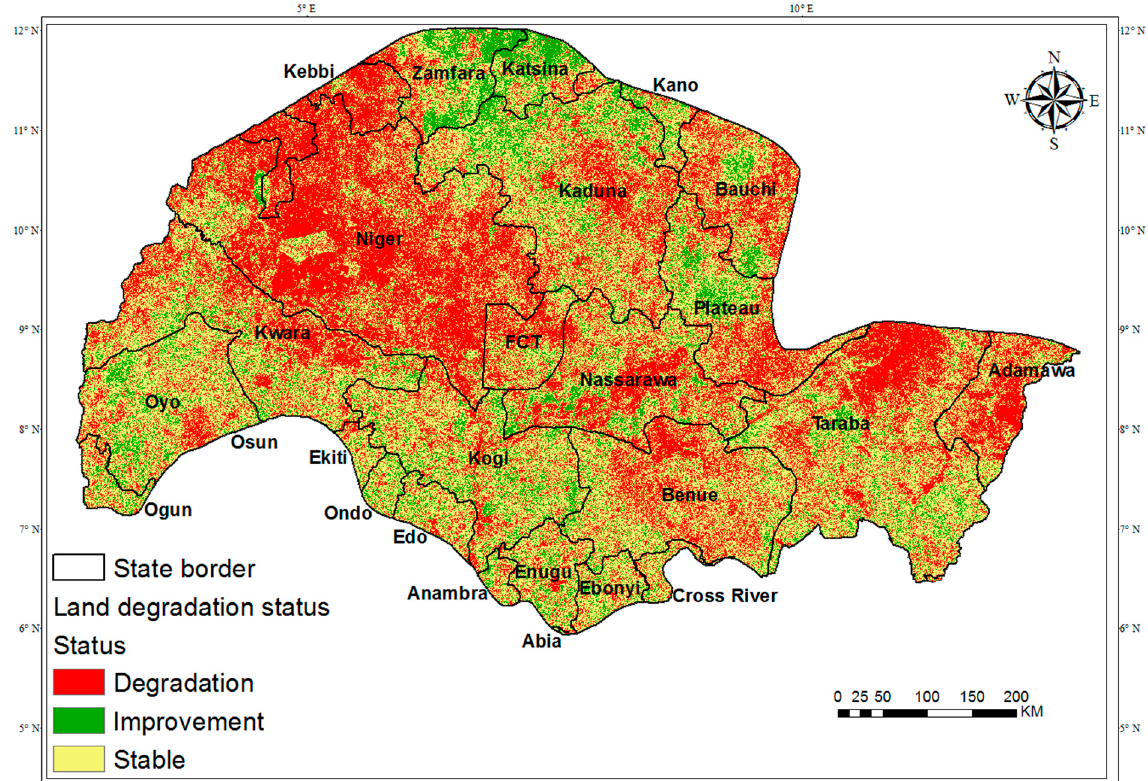
Figure 4. Land-degradation (LD) status for the Nigerian Guinea Savannah (NGS) (Source [11]) using Normalized Difference Vegetation Index (NDVI) as a proxy after correcting for rainfall.